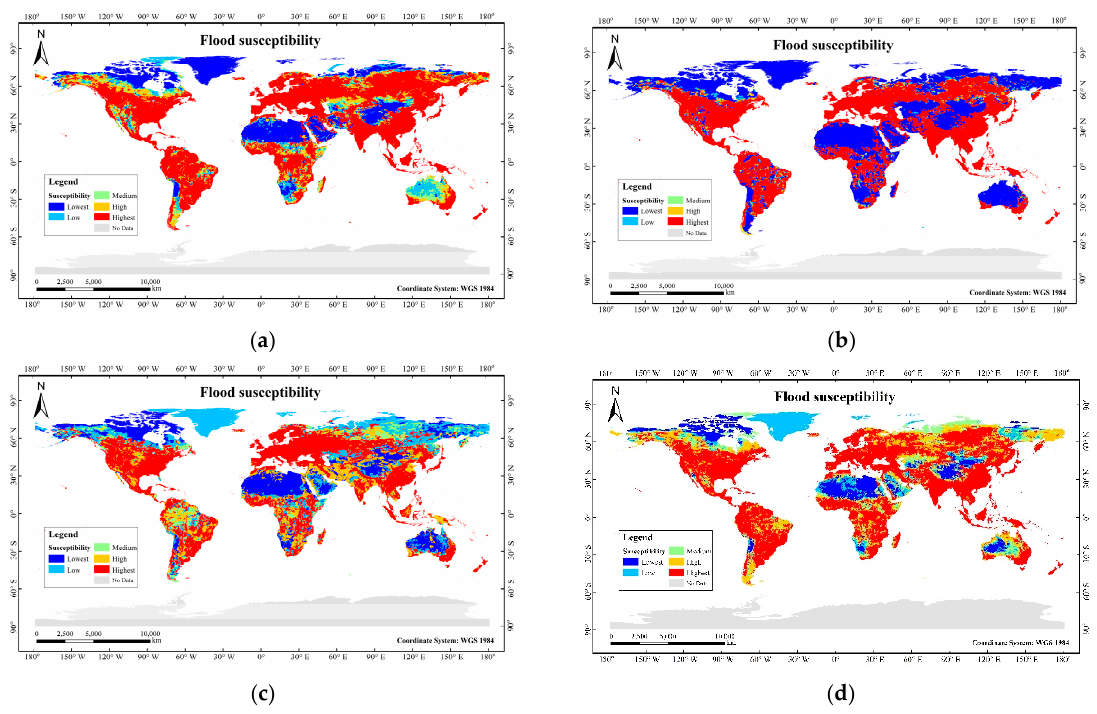
Figure 4. The global flood susceptibility map: ( a ) LR, ( b ) NB, ( c ) AB, and ( d ) RF. Table 3. Susceptibility level for each model of fourth-level watersheds.